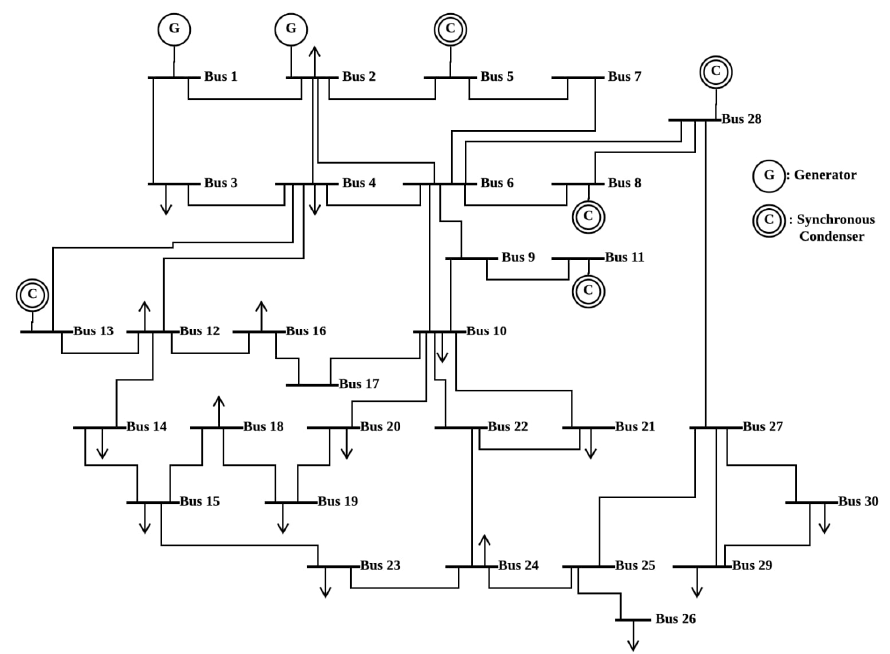
Figure 3. IEEE 30-bus test system.